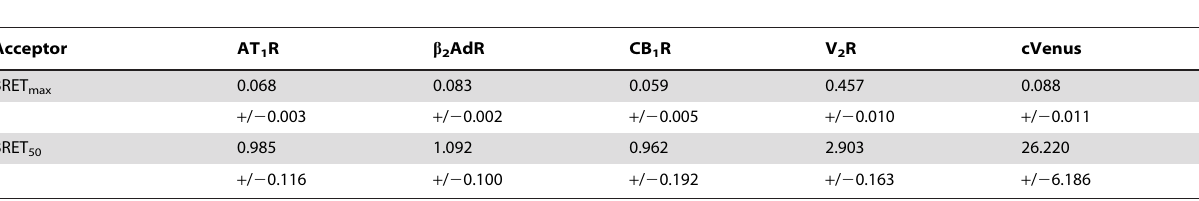
BRET max and BRET 50 values were calculated for experimental data (Figure 1B, left panel) using a non-linear regression equation assuming a single binding site (GraphPad Prism). Data are given as best fit value + / 2 Std.